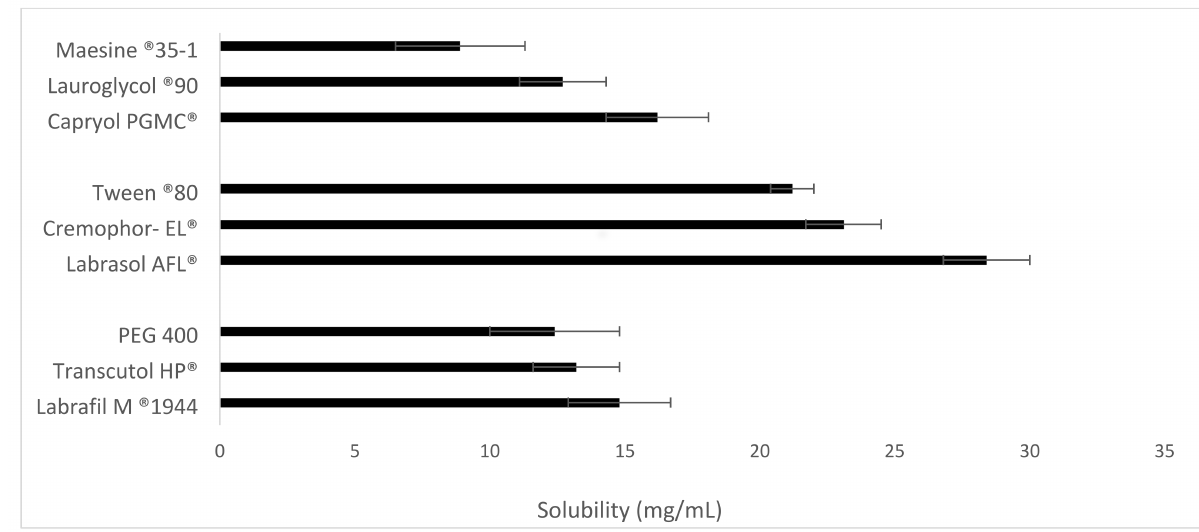
Figure 1. Solubility of Vox (mg/mL) in various oils, surfactants, and cosurfactants at 37 ◦ C. Data are expressed as the mean ± SD, n =